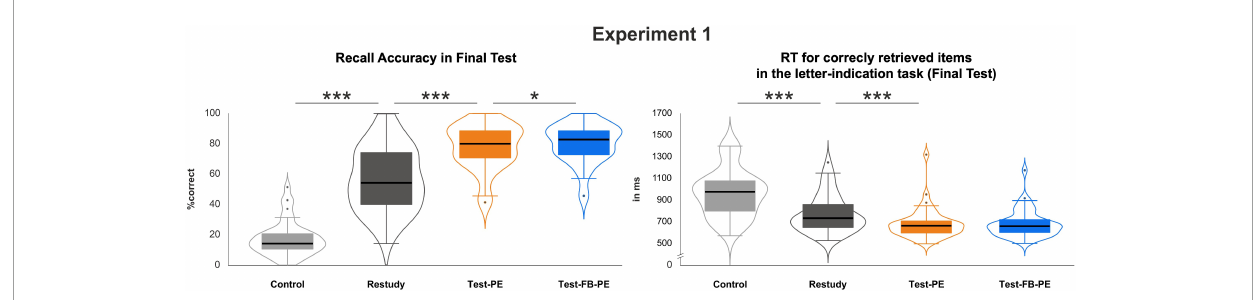
FIGURE2 Recall accuracy and RT results at final test as a function of repetition condition for Experiment 1. Note that the control condition (i.e., items studied only once) in Experiment 1 is associated with both lowest recall accuracy and highest RTs. The intervention benefit is evident in terms of both increased accuracies and decreased RTs. * p < 0.05 and *** p <